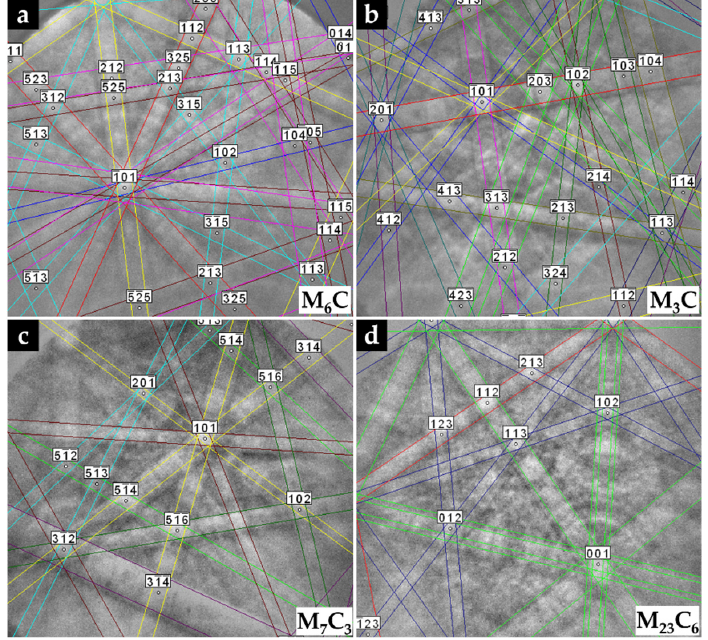
Figure 19. Indexed EBSD patterns of the carbides in CZ2 composite zone: (Fe,W,Cr) 6 C ( a ), (Fe,W,Cr) 3 C ( b ), (Fe,Cr,W) 7 C 3 ( c ), and (Fe,Cr,W) 23 C 6 ( d ).